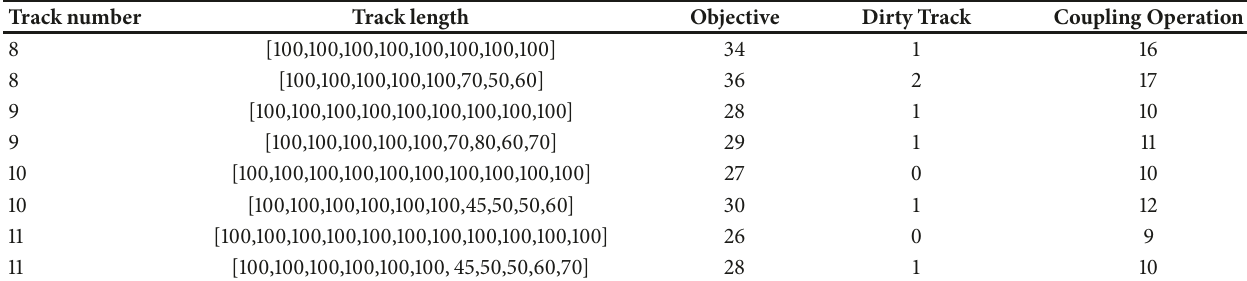
Table 7: Variation in track length and track